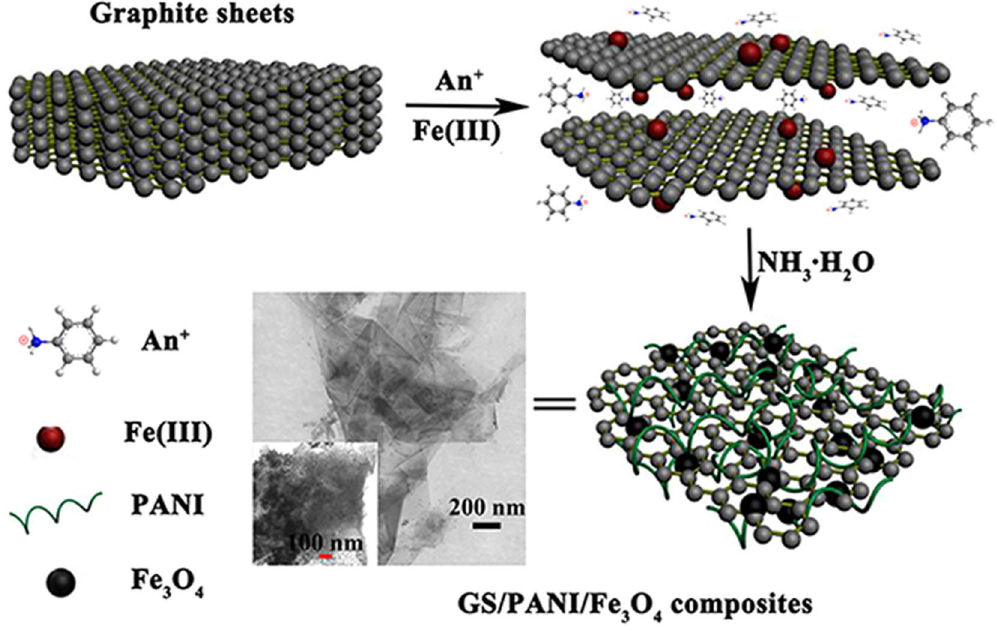
Figure 1. Illustration for the fabrication of superparamagnetic graphene/polyaniline/Fe 3 O 4 nanocomposites via in situ intercalation polymerization and co-precipitation